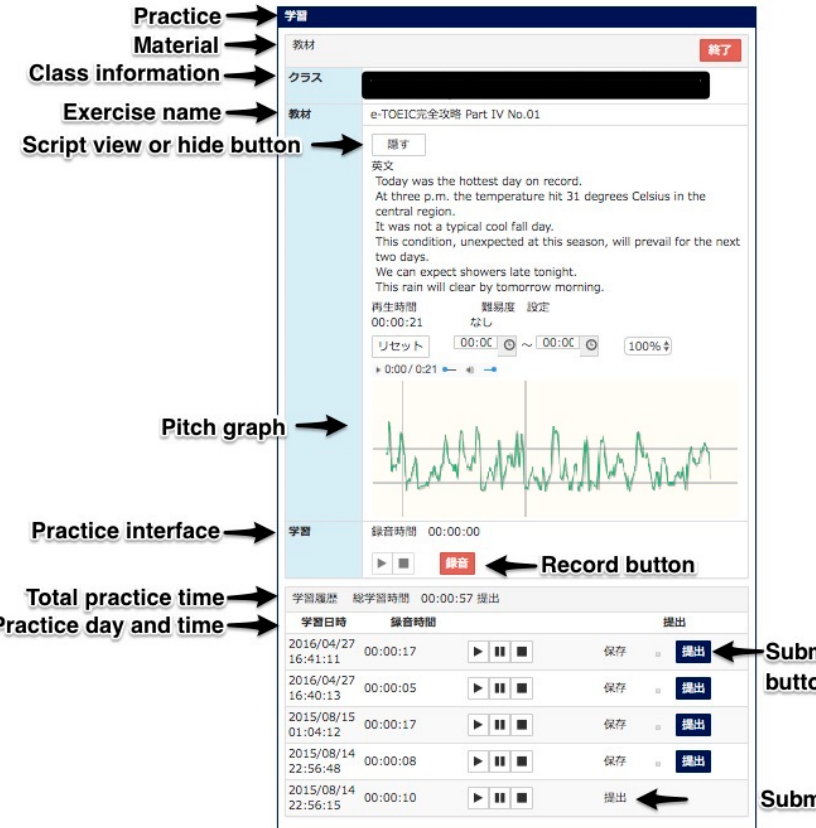
Figure 2. Shadowing recording screen with English translation.